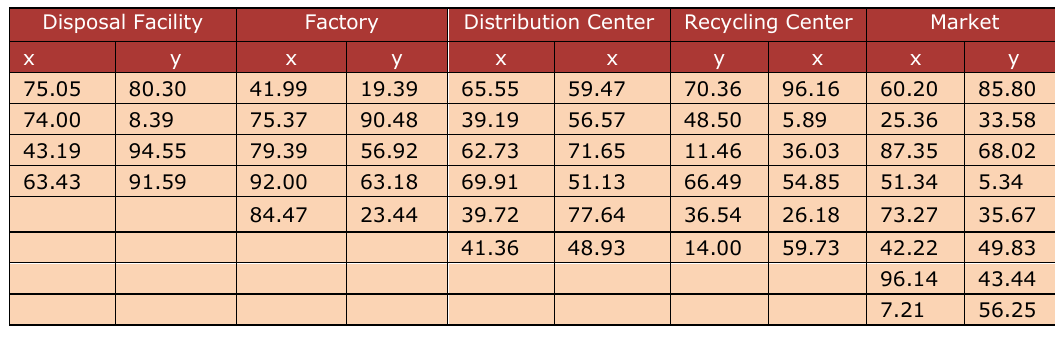
Table 2. Potential Locations’ Coordinates